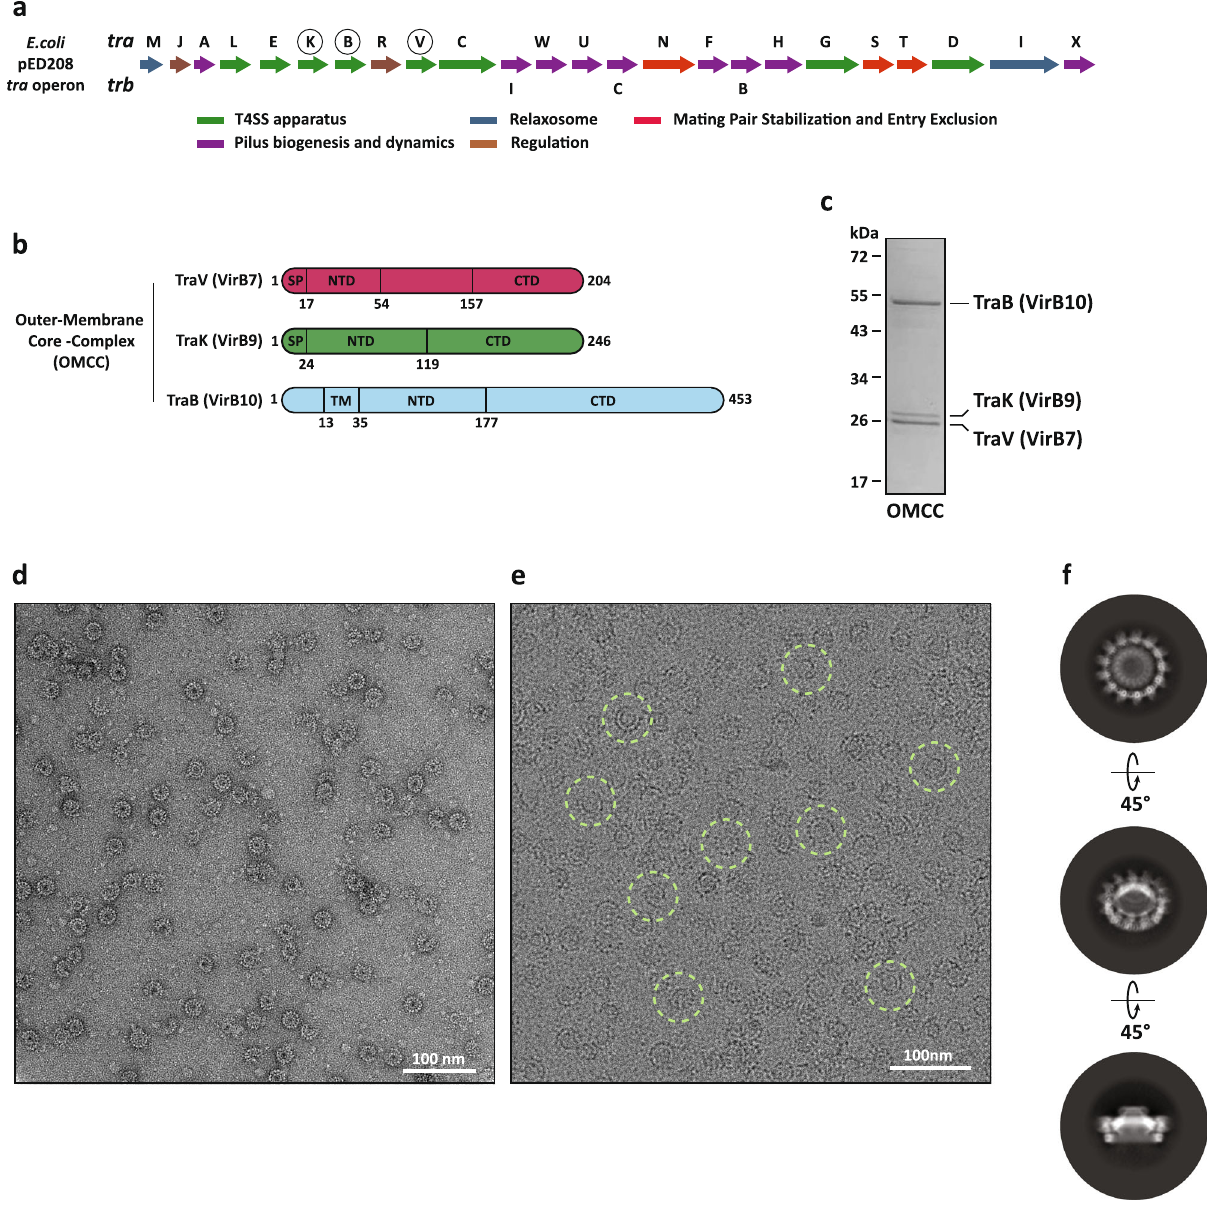
Fig. 1 The genetic organisation, biochemistry and EM analysis of the F plasmid outer membrane complex. a The native arrangement of T4SS-associated genes within the pED208 tra operon with the arrows representing the genes encoding for the T4SS apparatus (green), relaxosome components (blue), mating pair stabilisation and entry exclusion (red), pilus biogenesis and dynamics (purple), and regulation (brown). b The primary sequence structure of the three proteins TraV (purple), TraK (green) and TraB (cyan) including their domains and boundaries. c SDS-PAGE of the OMCC with the bands of the proteins TraB (VirB10), TraK (VirB9) and TraV (VirB7). d Negative stained EM micrograph of the OMCC. Scale bar 100 nm. e Cryo-EM micrograph of the OMCC, with particles highlighted with green circles. Scale bar 100 nm. f Representative top-, tilted- and side-view 2D class averages obtained using CryoSparc v3.1.0 (see 'Methods' section for detailed